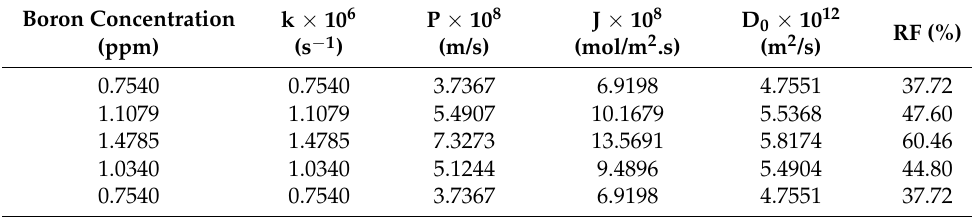
Table 2. Effect of boron concentration.